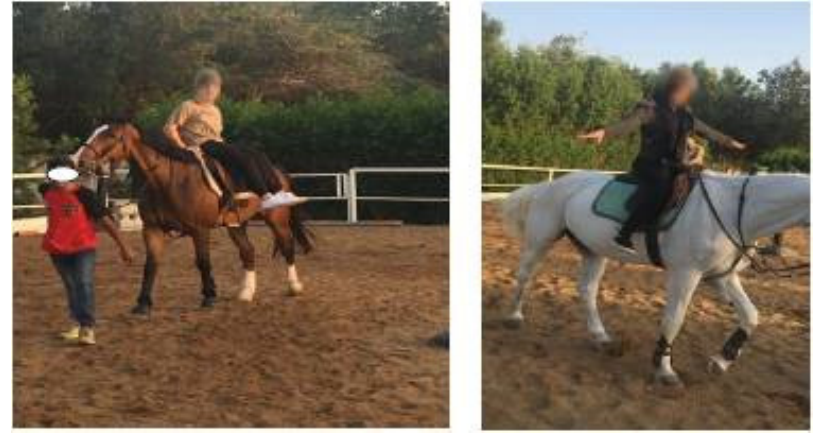
Figure 3. Horse-riding exercise training.